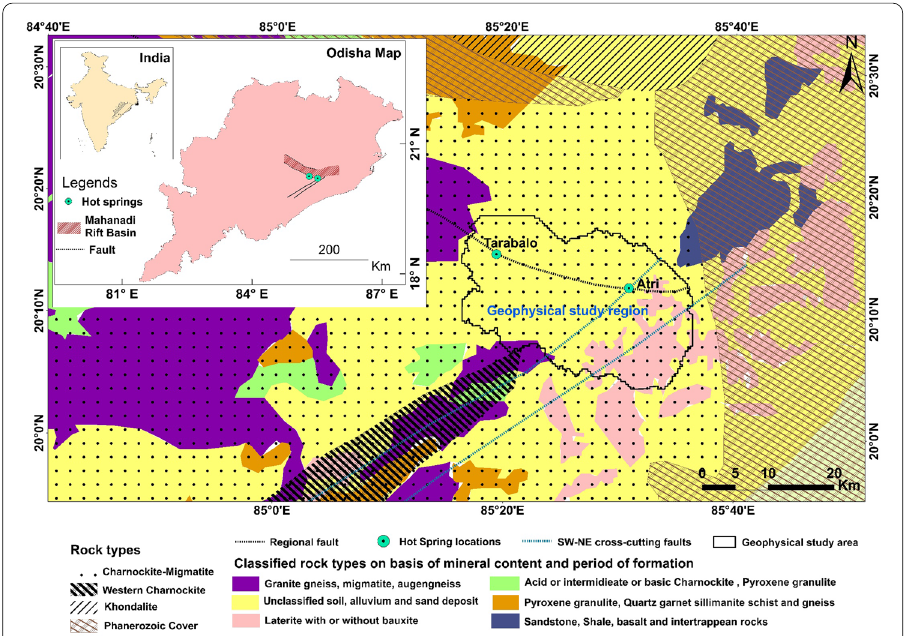
Fig. 1 Geology map of the study area, showing relative location of Mahanadi rift basin, in Odisha, India (inset), different rock types, and fault network (modified after Sharma 2009; Chandrasekharam and Chandrshekar 2010; Chaudhuri 2010; and Mandal et al.